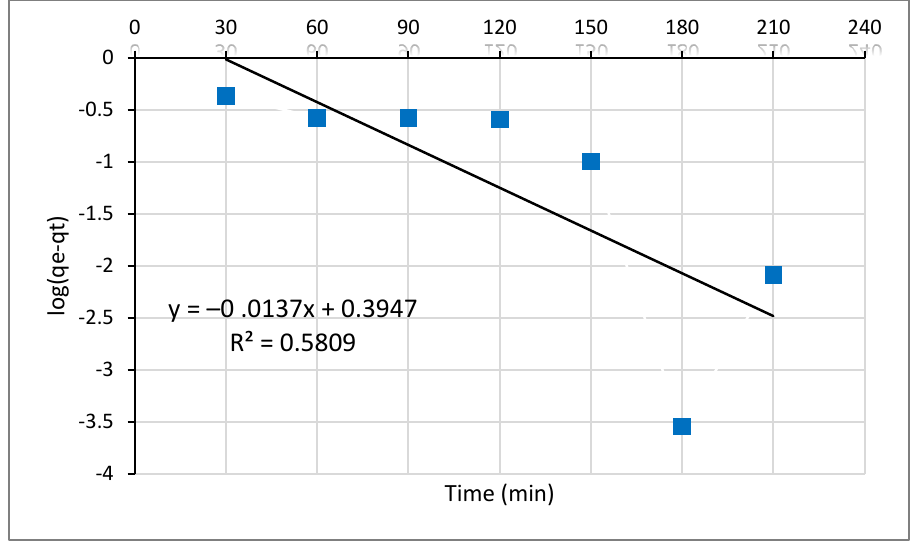
Figure 8. Pseudo-first-order kinetics plots for the adsorption of Pb 2+ ions onto the Odaracha adsor- bent.